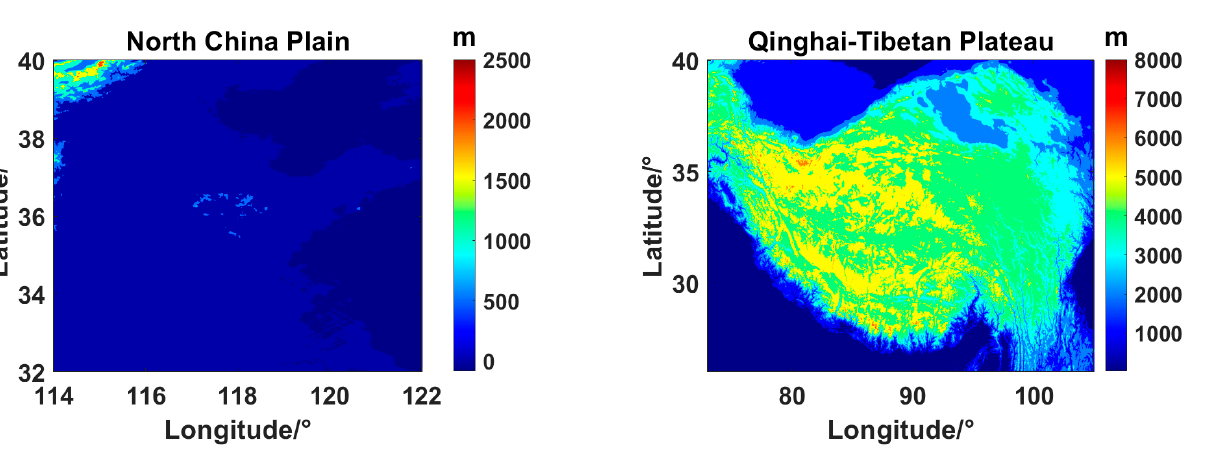
Figure 1. Topography maps.